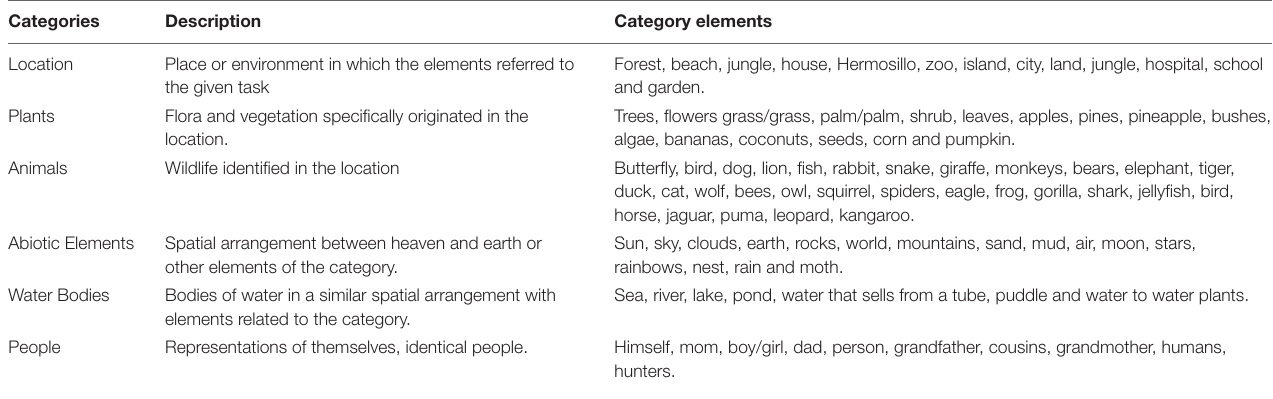
TABLE 1 | Coding scheme and description of the study